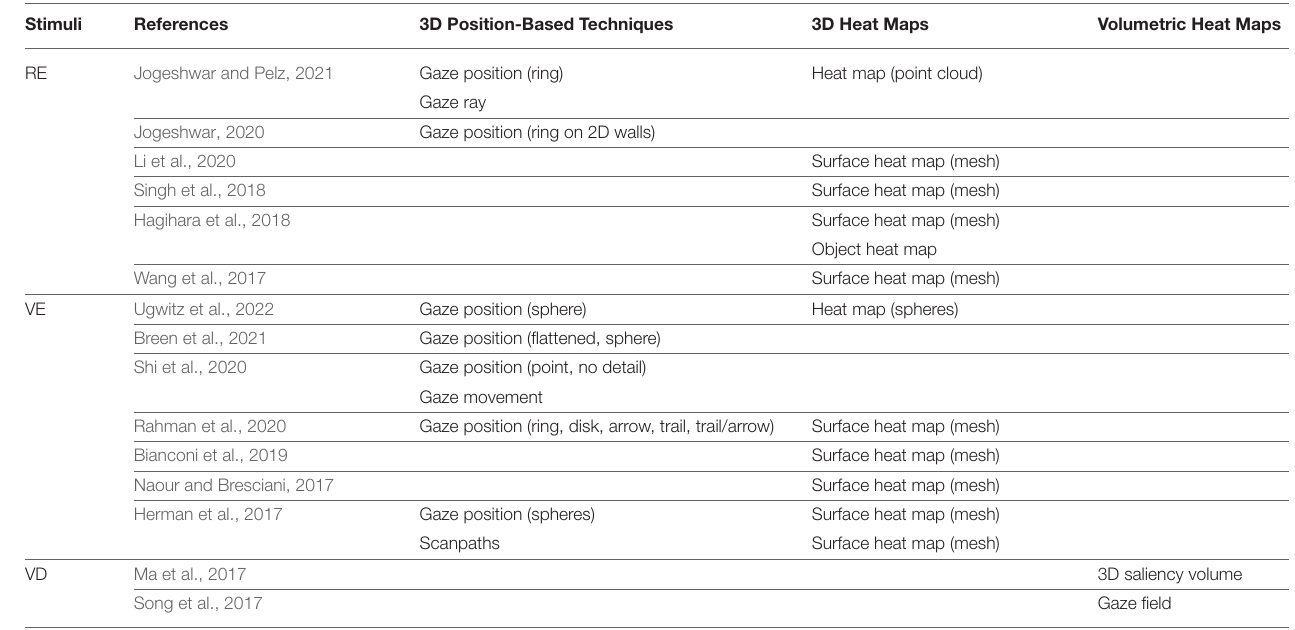
TABLE 2 | 3D visualization techniques used in the analyzed papers. The papers are clustered per stimuli type: real environment (RE), virtual environment (VE), and volumetric dataset (VD).